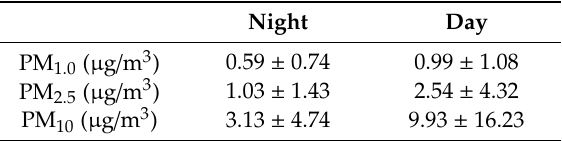
Table 3. Mean PM concentrations recorded with the OPC-N3 during the nighttime and daytime. The t -test showed that results were statistically significant at the 95% confidence level.